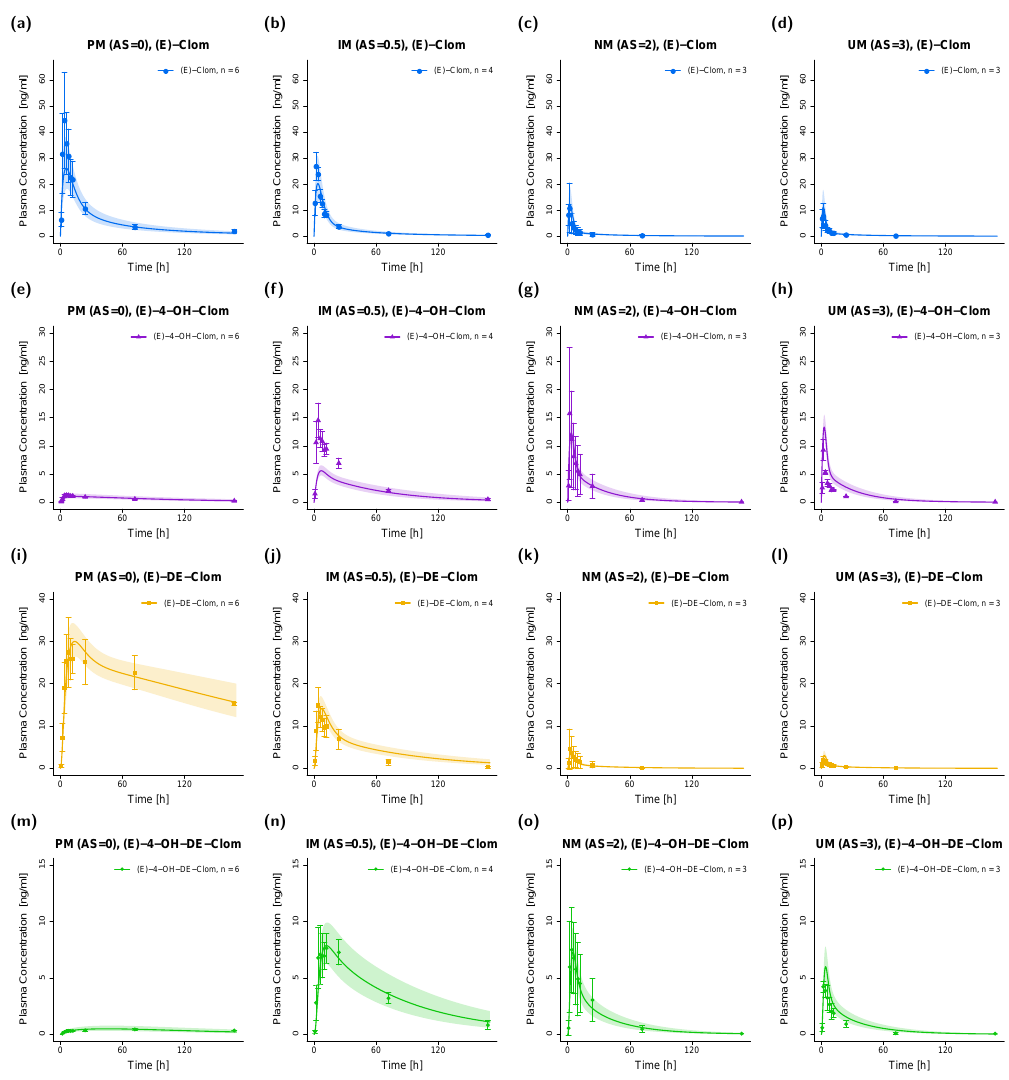
1 Figure 3. Predicted and observed plasma concentration–time profiles of ( E )-Clom ( a – d ), ( E )-4-OH- Clom ( e – h ), ( E )-DE-Clom ( i – l ) and ( E )-4-OH-DE-Clom ( m – p ) in PM (first column), IM (only AS = 0.5 shown; second column), NM (third column) and UM (last column) for DGI scenarios. Solid lines depict predicted geometric mean concentration–time profiles in the PM, IM (AS = 0.5), NM and UM populations. Colored ribbons show the corresponding geometric standard deviation of the population simulations ( n = 1000). Mean observed data are shown as symbols with the corresponding standard deviation. Linear and semilogarithmic predicted and observed plasma concentration–time profiles of all studies and AS are shown in Section S4.1 of the supplementary document. AS, CYP2D6 activity score; DGI, drug–gene interaction; ( E )-4-OH-Clom, ( E )-4-hydroxyclomiphene; ( E )-4-OH- DE-Clom, ( E )-4-hydroxy-N-desethylclomiphene; ( E )-Clom, ( E )-clomiphene; ( E )-DE-Clom, ( E )-N- desethylclomiphene; IM, intermediate metabolizers; n , number of subjects; NM, normal metabolizers, PM, poor metabolizers; UM, ultrarapid